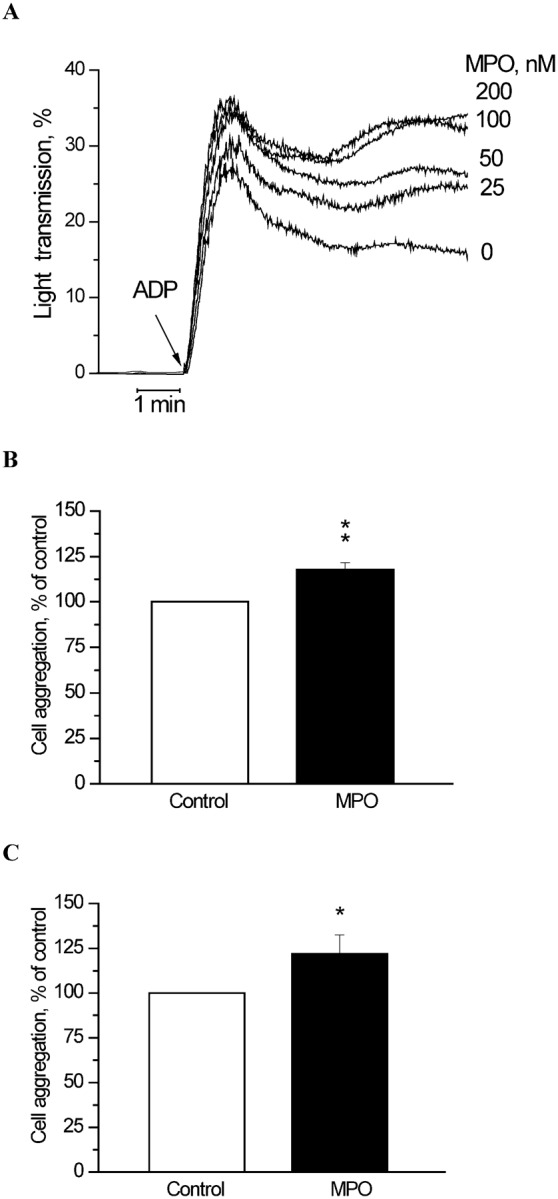
Effect of MPO on human platelet aggregation.(A) Typical kinetics of ADP-induced aggregation of PRP treated with different concentrations of MPO as specified on the curves (25–200 nM). ADP was used at concentration of 1 µM. Typical kinetics of three independent experiments are presented. (B) The rate of platelet aggregation activated by thrombin (48.4 mU/ml) in the presence of MPO (100 nM). (C) The extent of ADP-induced platelet aggregation (amplitude) in whole blood in the presence of MPO (100 nM). ADP was used at concentration of 5 µM. Each data point in panels B and C corresponds to mean ± s.e.m. of three independent experiments. *P<0.05; **P<0.01. In all cases platelets were treated with MPO for 2 min before adding the agonists.